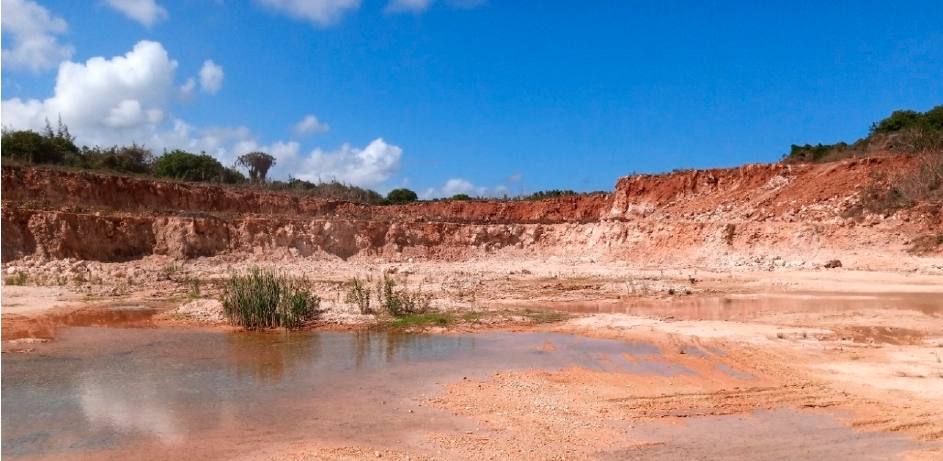
Figure 2. Ocean water visible in the quarry floor during high tide.